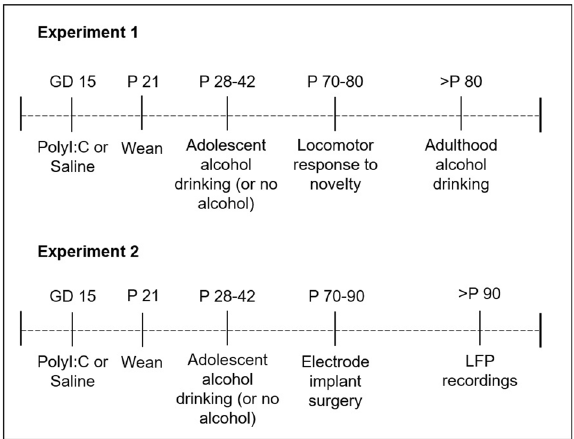
Fig. 1 Experimental timelines. Dams were exposed to polyI:C or saline on gestational day (GD) 15. Half of the offspring were then exposed to continuous alcohol from postnatal day (P) 28-42. Behavioral and electrophysiological experiments began in adult- hood (>P